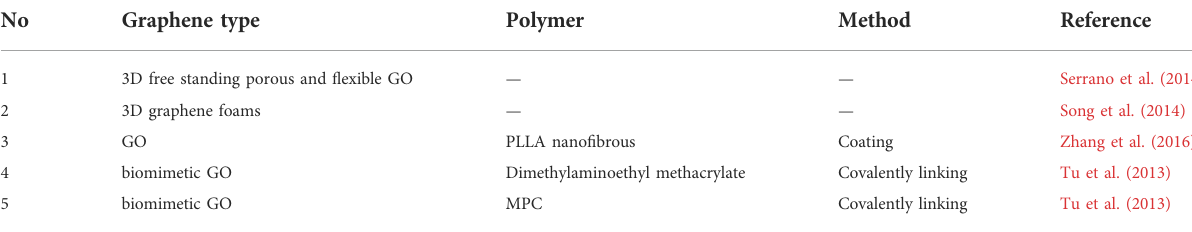
TABLE 4 A list of graphenes with polymers for neuronal tissue